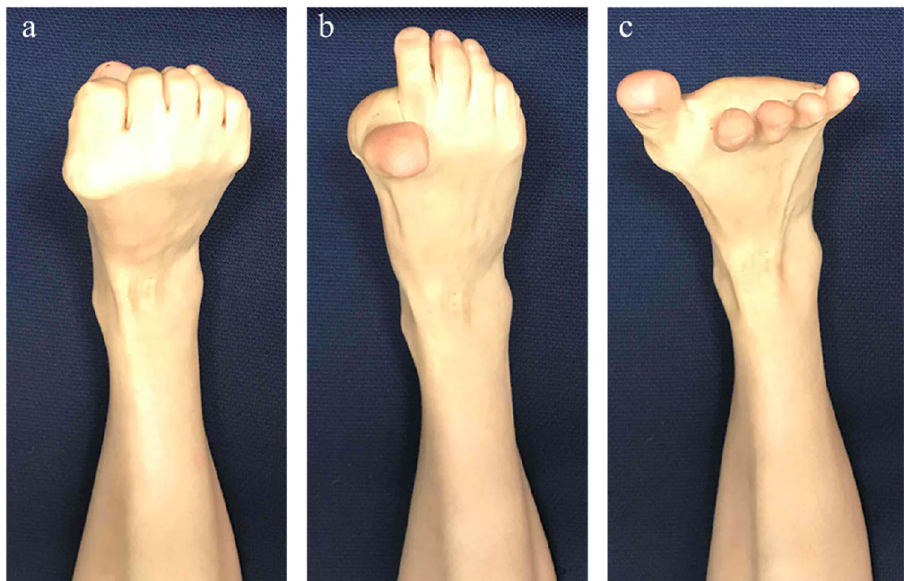
Figure 1. The foot rock-paper-scissors exercise. Repetition of the following movement sequence: fold the toes ( a ), spread the toes out ( b ), and extend the first toe ( c ).